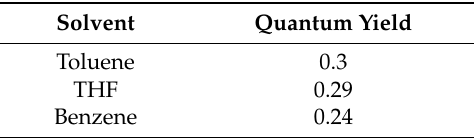
Table 1. Quantum yield of conjugated PFO-co-pX polymer in different solvents.